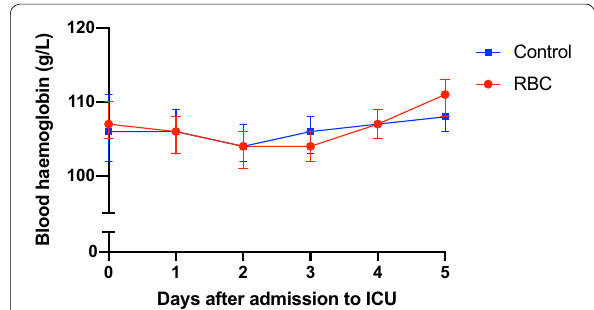
Fig. 5 Median hemoglobin level with interquartile range in the sensitivity analysis that included hemoglobin level day 0 in the matching. RBC group with patients who received red blood cell = transfusion any of the first 5